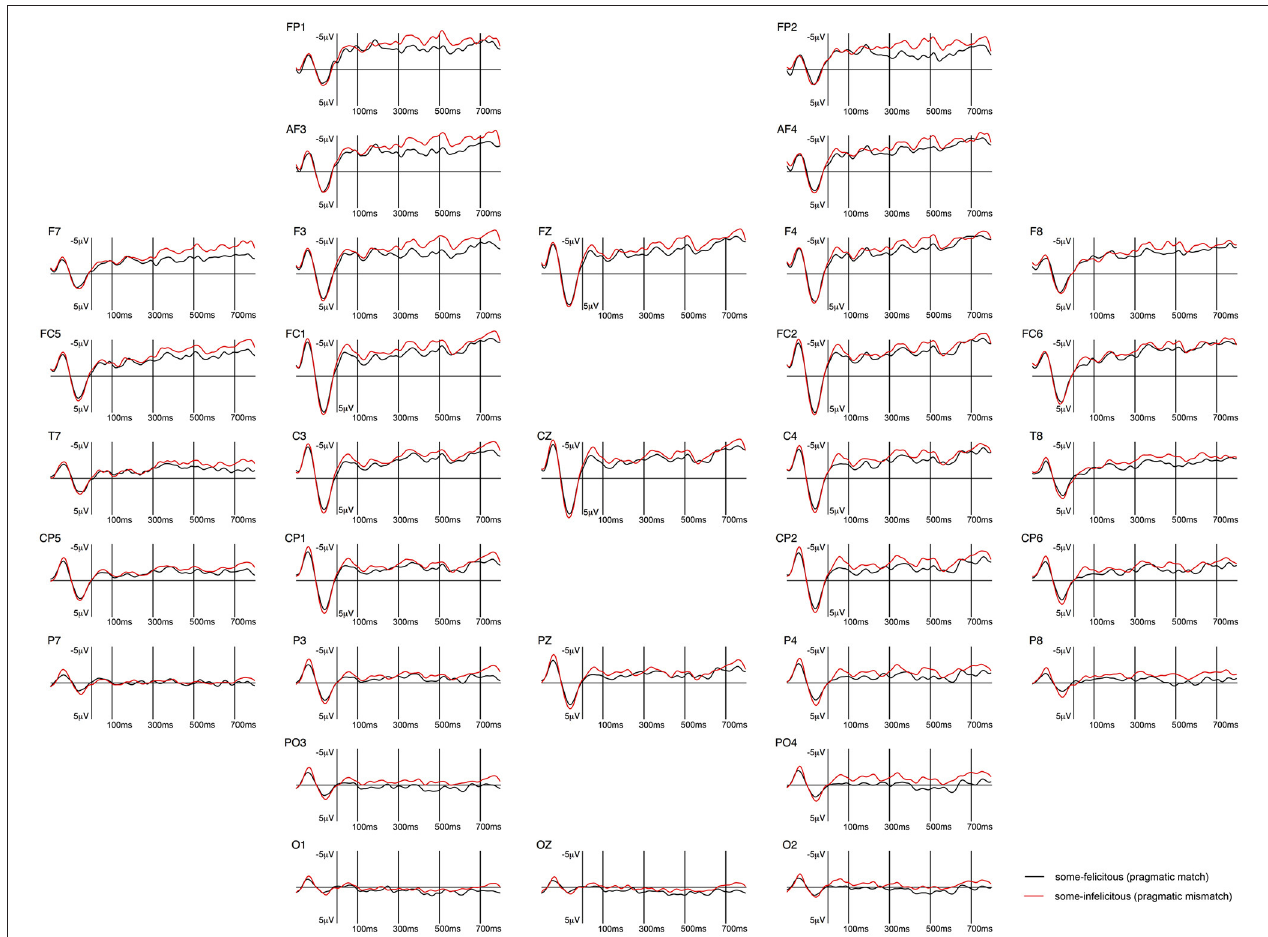
FIGURE 7 | Grand-averaged ERPs recorded in adults, time-locked to the presentation of the word “Ein paar” ( some ) for the some -felicitous condition (black line) compared to the some -infelicitous condition (red line).